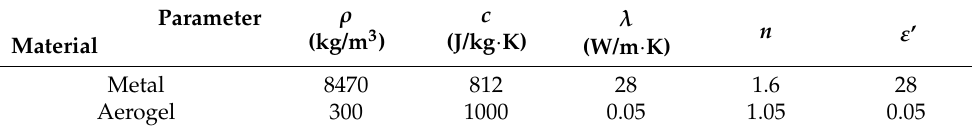
Table 2. The physical